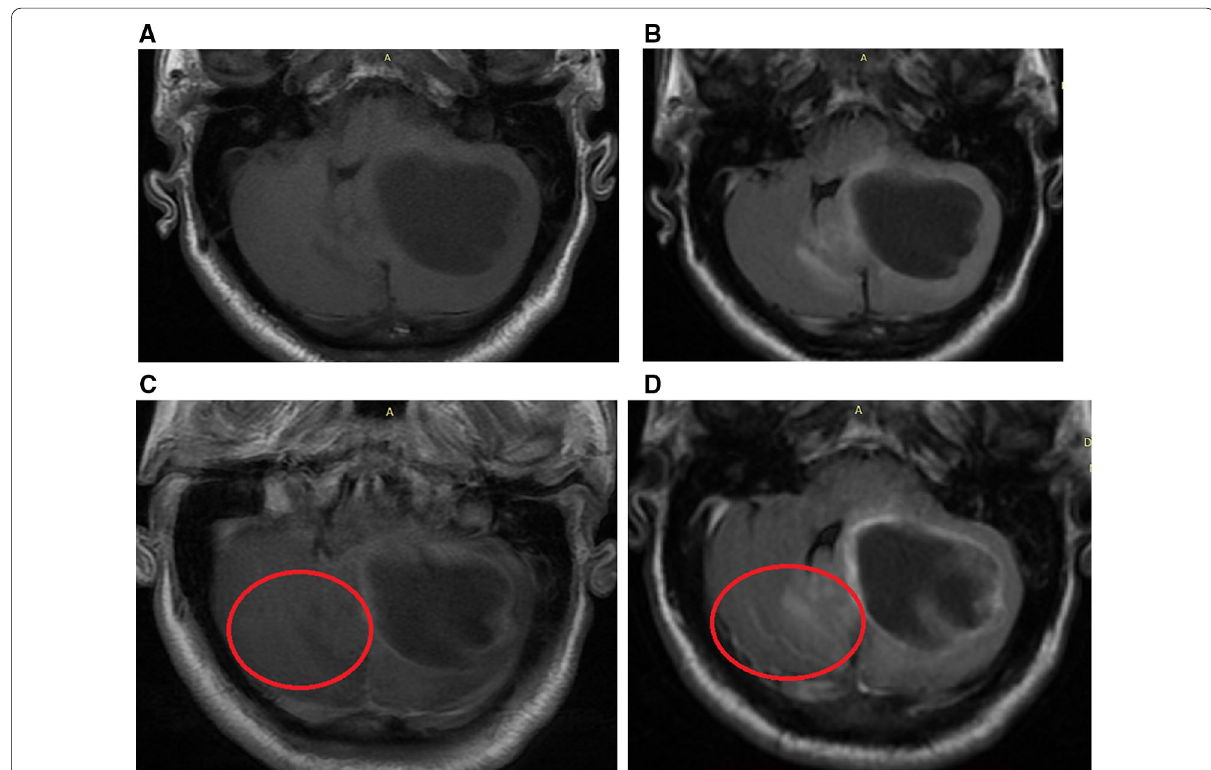
Fig. 1 Male patient aged 49 years, with known prostatic cancer, presented with dizziness and vertigo. The right cerebellar hemisphere shows leptomeningeal enhancement, which is noted only at delayed post-contrast FLAIR(D red circle), with no enhancement seen in post-contrast T1 (C). A : Axial pre-contrast T1WI. B Axial FLAIR., C Axial CE-T1WI. And D Axial